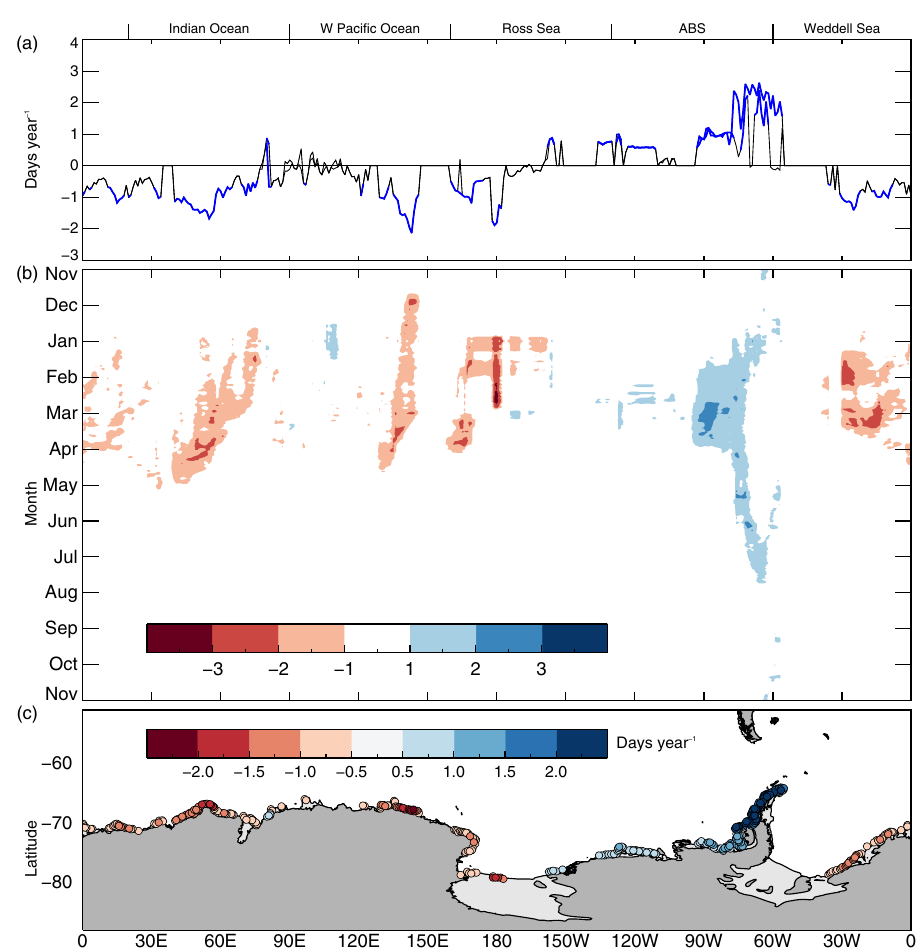
Fig. 6 Trends (1979 – 2020) of annual coastal exposure events based on coastal exposure length. a Each longitude (days year − 1 ), b each longitude and day (occurrence per decade), and c each coastal grid point (days year − 1 ). Statistically signi fi cant values (>95% con fi dence) for ( a ) are highlighted in blue. Only statistically signi fi cant values (>95% con fi dence) are plotted on ( b ) and ( c ). For ( c ), grid points with higher magnitude of trends are plotted over those with lower